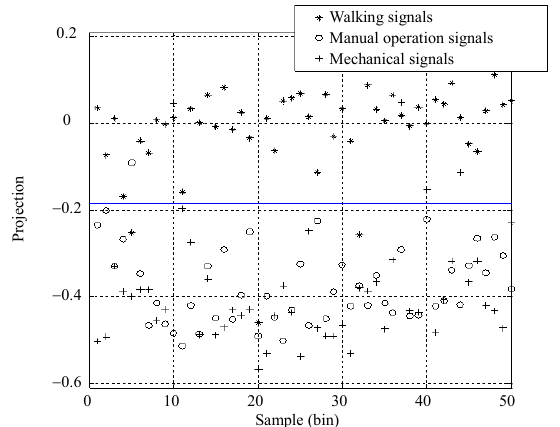
Fig. 10 Classification results of walking signals (Sample 1) and manual operation signals & mechanical signals (Sample 2).